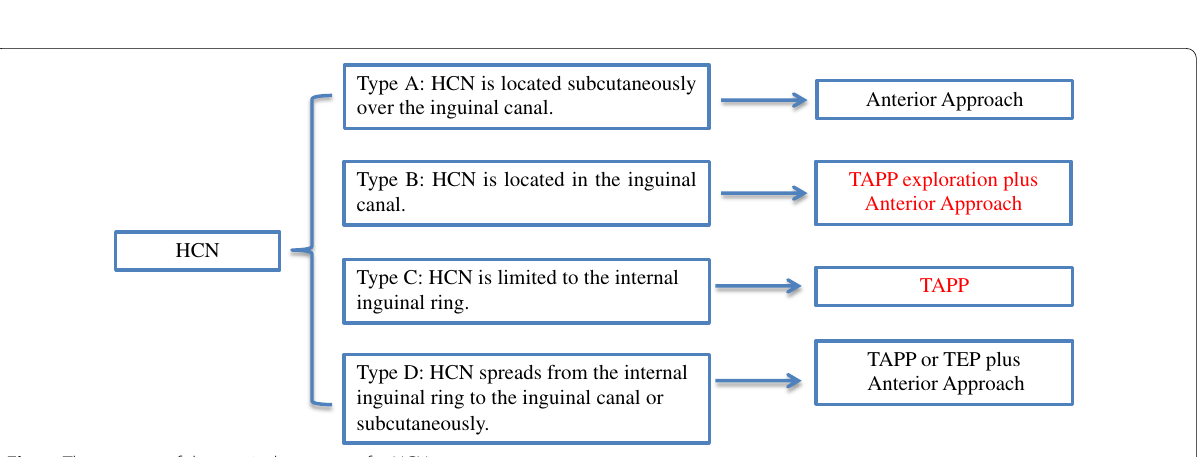
Fig. 5 The strategy of the surgical treatment for